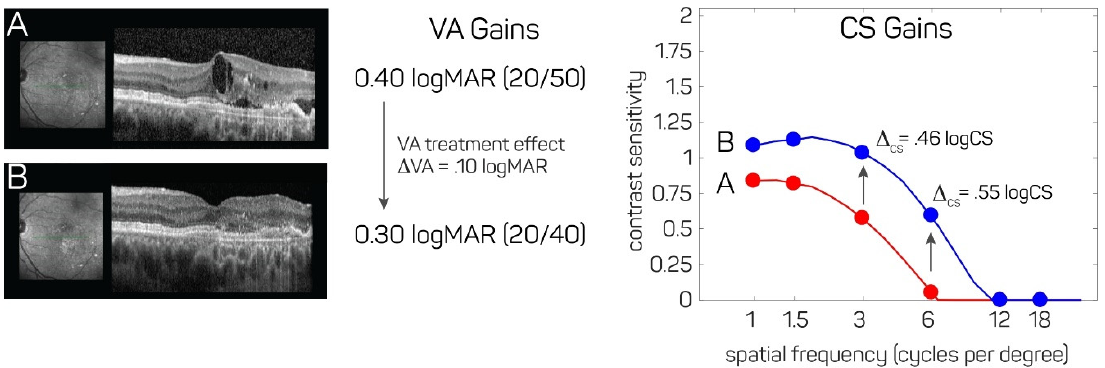
Figure 4. Representative example of a patient with neovascular (wet) AMD before and after an anti-VEGF injection, where treatment effect measured with contrast sensitivity is many times larger than treatment effect measured with visual acuity. On the left side of the figure are OCTs before ( A ) and after ( B ) the injection of an anti-VEGF agent showing resolution of intraretinal and sub retinal fluid. The improvement in VA ( Δ VA) is only 0.1 LogMAR (1 line), from 0.40 LogMAR (20/50) to 0.30 LogMAR (20/40), yet the improvement in contrast sensitivity thresholds ( Δ cs) is many times larger, 0.46 LogCS at 3 cpd and 0.55 LogCS at 6 cpd (previously unpublished figure).